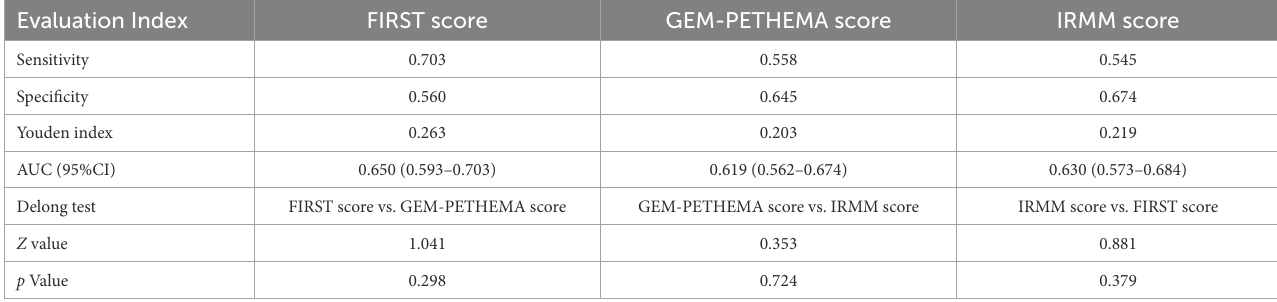
TABLE 3 Comparison of prediction performance in three